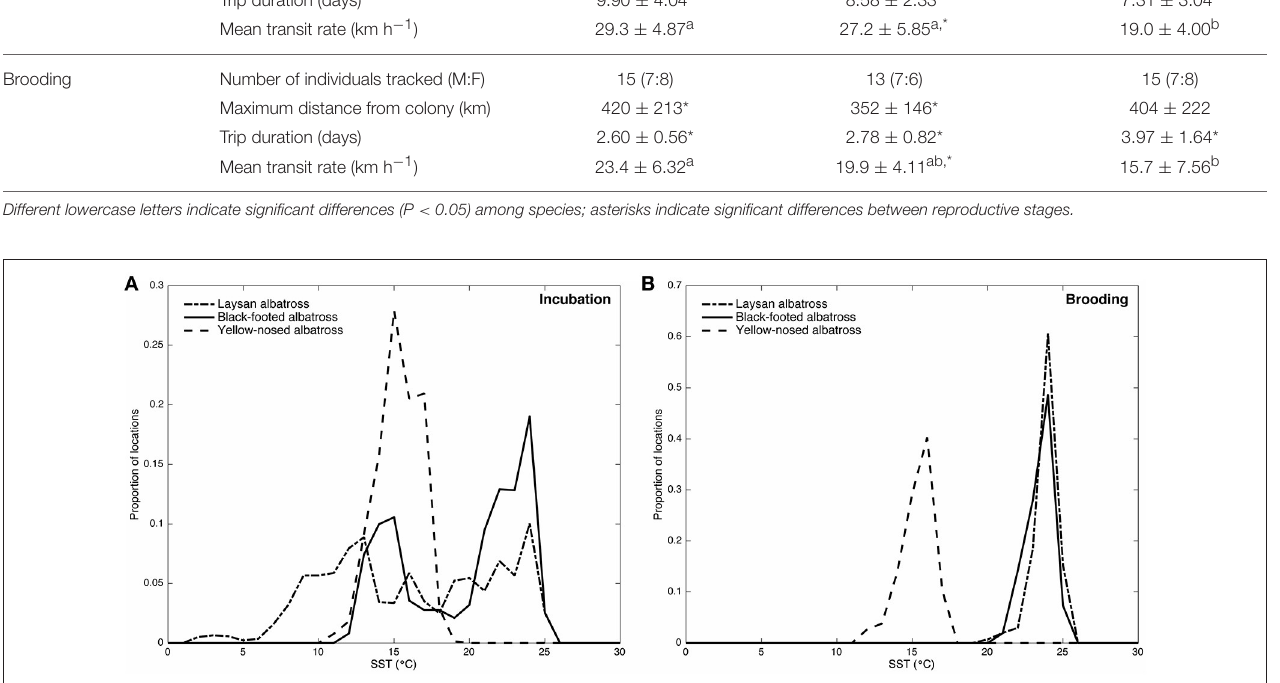
during brooding (8 km h − 1 on average; P = 0.004), but this was the only species difference in transit rate observed.